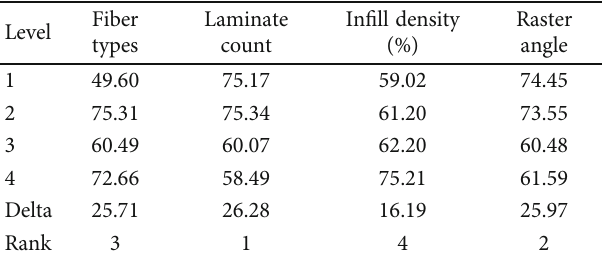
Table 7: Response table for means (shore